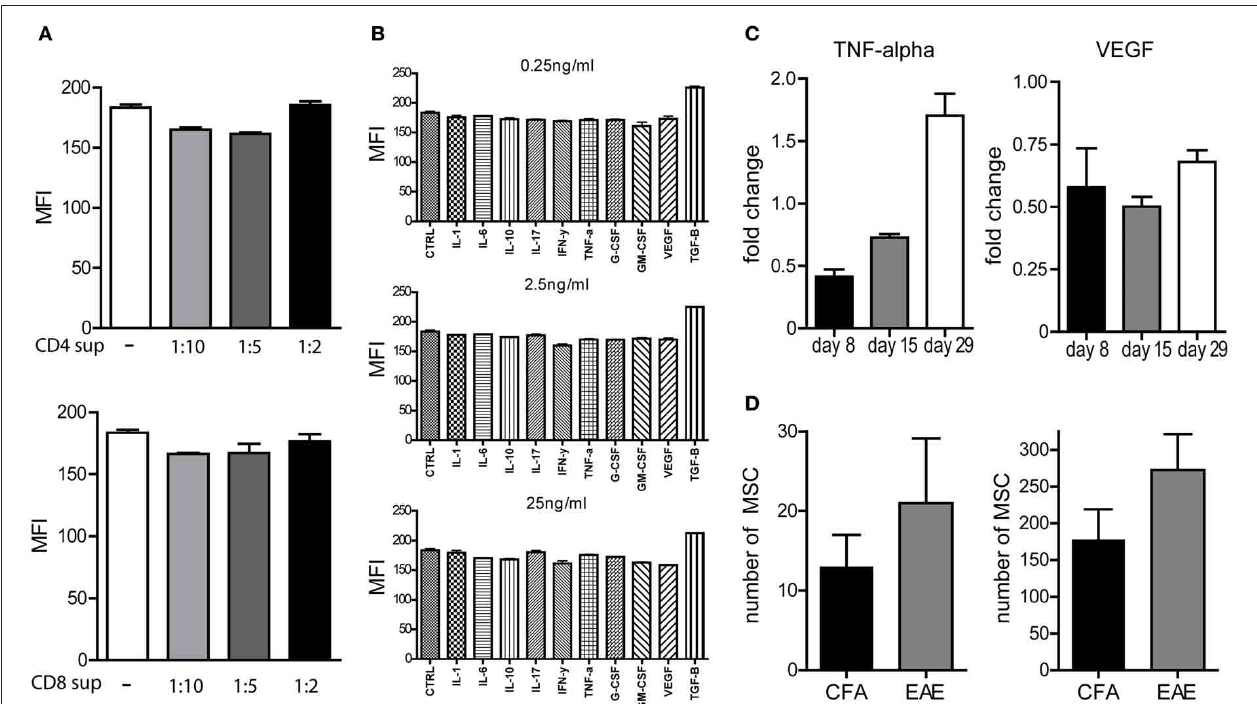
FIGURE 3 | Proliferation of MSCs not affected upon cytokine treatment. (A,B) In vitro proliferation of CFSE labeled bone marrow derived MSCs from healthy mice in the presence of different concentrations of supernatants from CD3/CD28 beads activated CD4 or CD8 T cells (A) or various growth factors or cytokines (B) during 72h measured by MFI of CFSE. Experiments were performed three times in duplo and a representative example is shown.